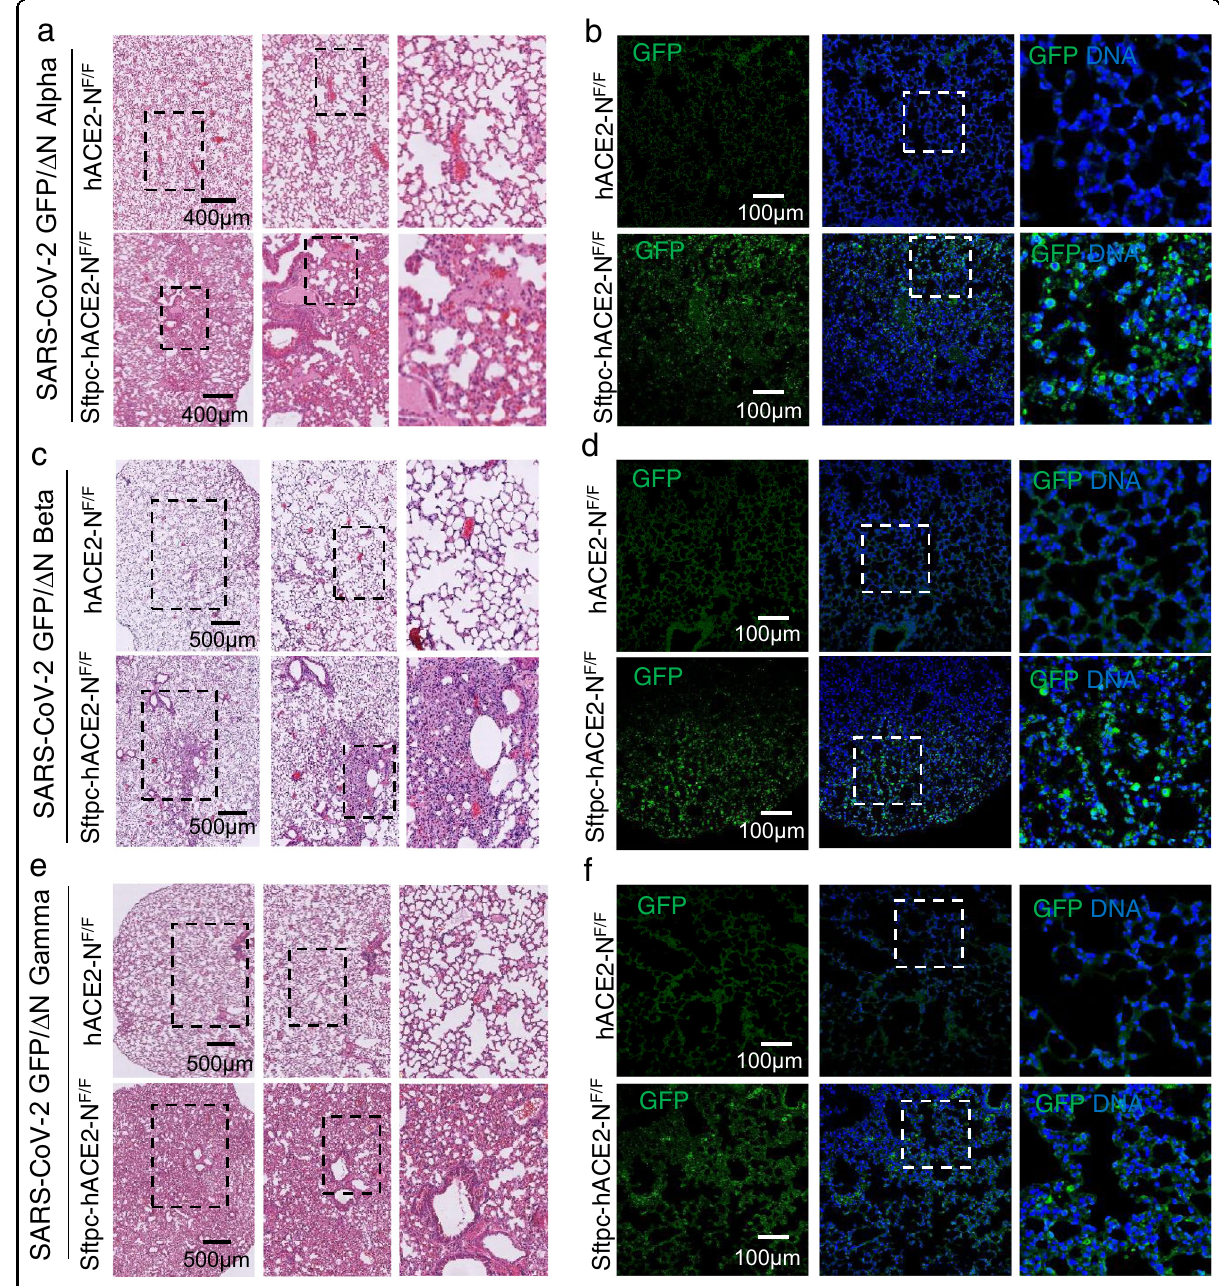
Fig. 3 SARS-CoV-2 GFP/ Δ N variants can infect Sftpc-hACE2-N F/F mice. a , c , e H&E staining shows the pathological changes in Sftpc-hACE2-N F/F mouse lung after infection with SARS-CoV-2 GFP/ Δ N Alpha ( a ), Beta ( c ), Gamma ( e ) variants. The dark frame blocks were magni fi ed on the right. b , d , f Immuno fl uorescence staining of mouse lungs for SARS-CoV-2 GFP/ Δ N GFP protein (green), and DAPI